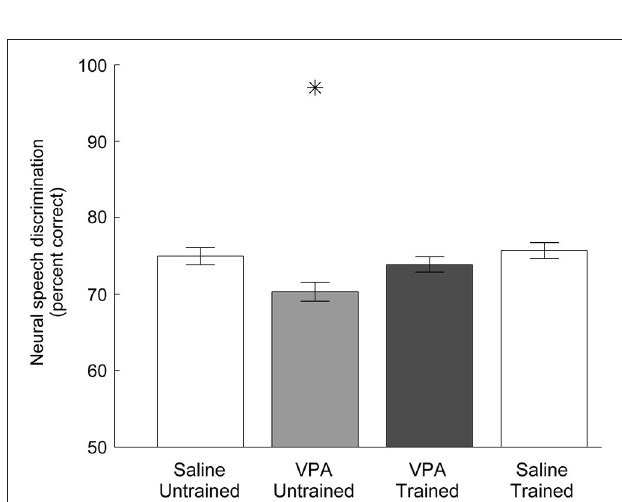
FIGURE 5 | Neural discrimination of speech sounds in AAF is restored in VPA speech trained rats . The classifier percent correct impairment in VPA untrained rats is restored in VPA speech trained rats. The classifier uses the 40 ms onset response with 1 ms precision to discriminate between pairs of consonants. Error bars indicate s.e.m. across AAF recording sites. Asterisks indicate groups that are statistically significant compared to VPA speech trained rats ( p <